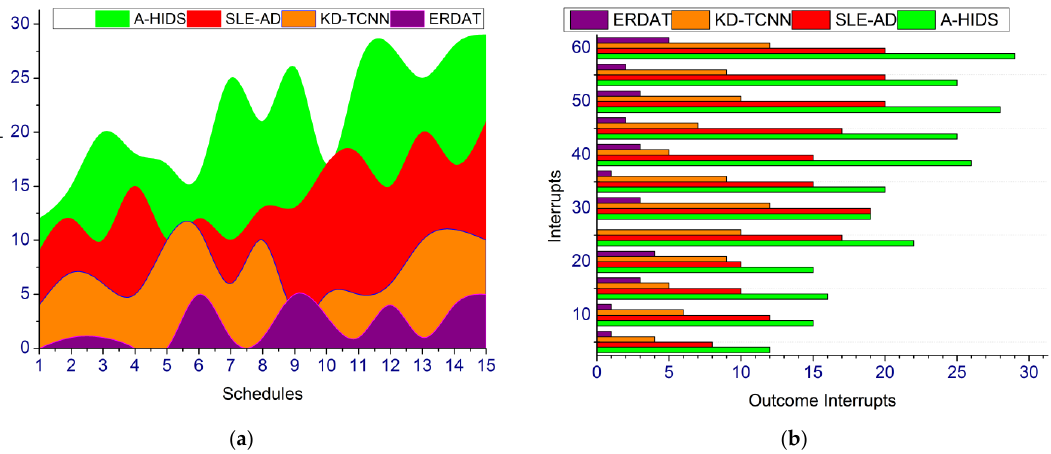
Figure 10. Outcome Interrupt. ( a ) Outcome Interupts. ( b ) Interupts.